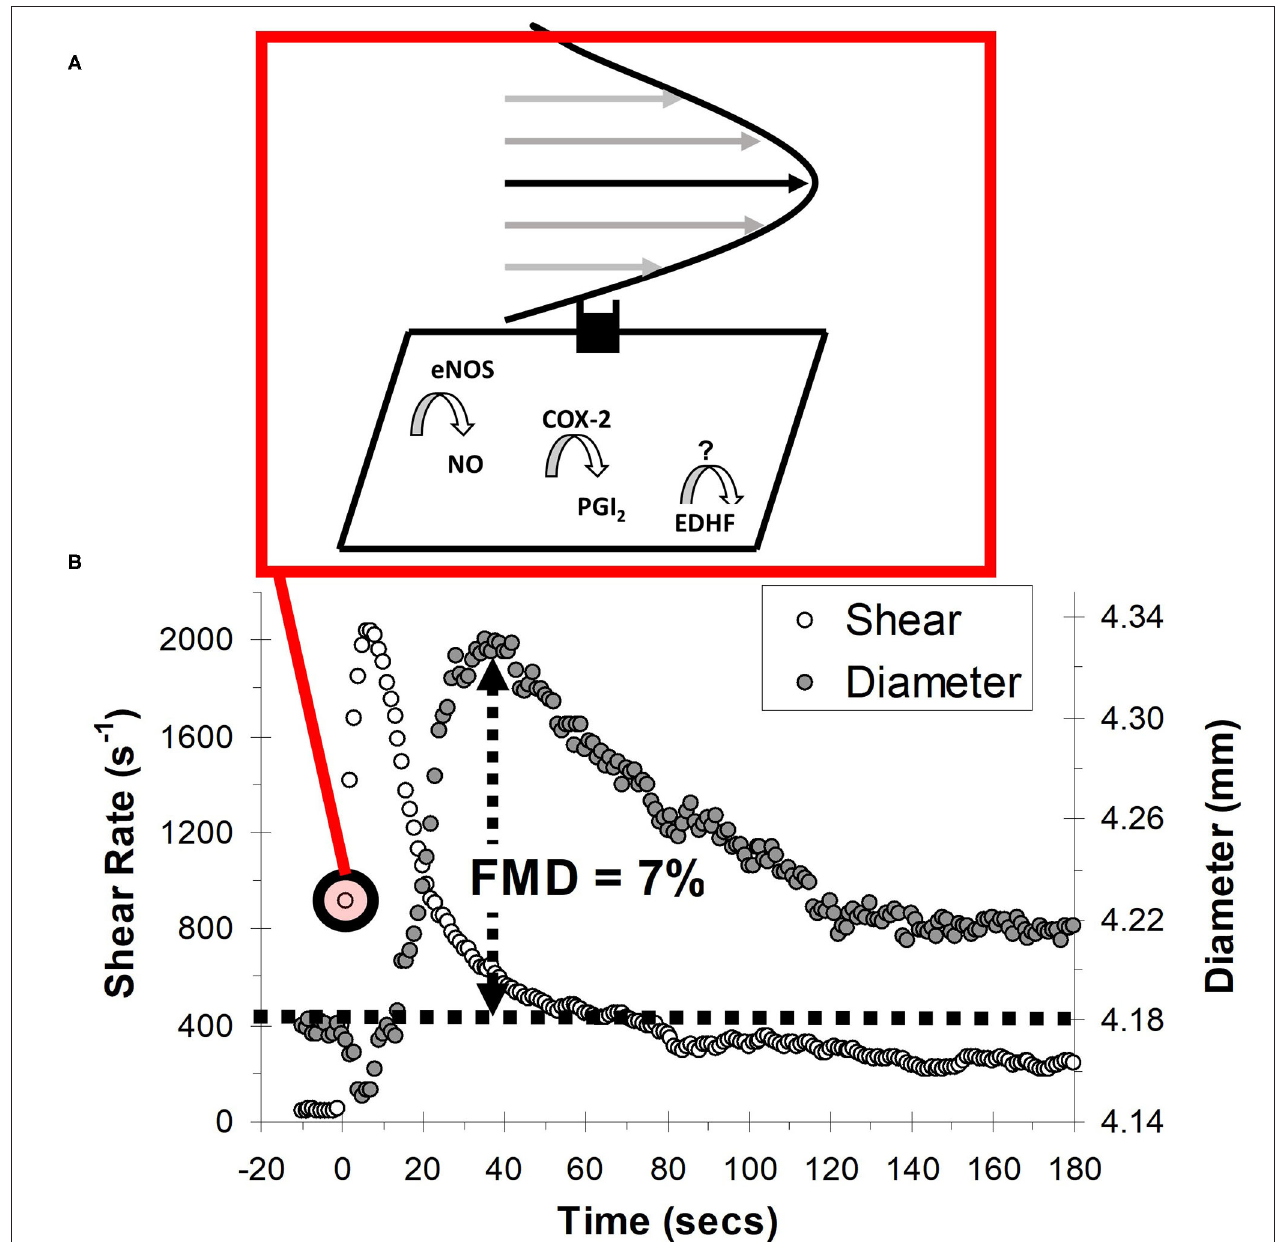
FIGURE 4 | Schematic of the flow-mediated dilation (FMD) test. (A) Shear stress created by red blood cells flowing past the vessel wall is detected by mechanoreceptors in the endothelium, triggering a signal cascade whereby vasodilators, nitric oxide (NO) prostacyclin (PGI 2 ) and endothelial hyperpolarizing factor (EDHF) are produced. Vasodilators subsequently diffuse to the vascular smooth muscle cells, prompting vasodilation. (B) Vessel diameter and shear rate responses before and after 5-min ischaemic stimulus. eNOS, endothelial nitric oxide synthase; COX-2, cyclooxygenase-2.